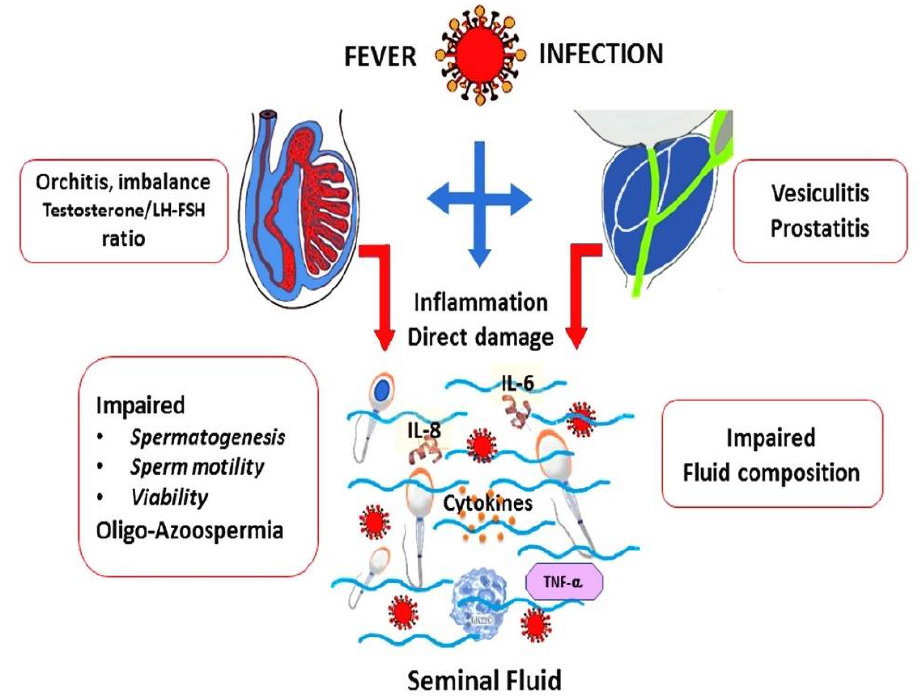
Figure 1. Once infection begins, the virus can affect the testes and prostate through the interaction with angiotensin I-converting enzyme 2 (ACE2) receptors and transmembrane serine protease. However, this complication does not occur in every patient with COVID-19 disease, being more likely in predisposed individuals with lengthy infection or fever. As the virus moves into their reproductive organs, seminal fluid and sperm characteristics are modified. Infection may also cause direct seminal fluid inflammation and sperm damage, with polymorphonucleate and lymphocyte activation, interleukins (IL-6, IL-8, others) and cytokine release, tumor necrosis factor (TNF- α ), etc. Most authors reported these as transient complications (see text).